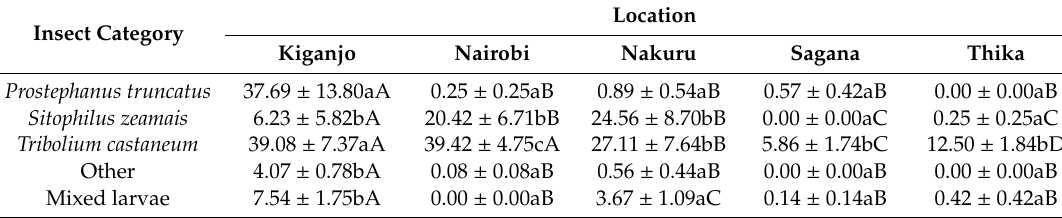
Table 1. Analysis of counts of insects captured per 50 kg bag in each warehouse (mean ± standard error of mean [SEM]). Means for di ff erent species in the same warehouse that are followed by the same (small) letter are not significantly di ff erent from each other ( p > 0.05). Means of the same species in di ff erent warehouses that are followed by the same (capital) letter are not significantly di ff erent from each other ( p > 0.05). Means were separated using the Bonferroni adjustment.